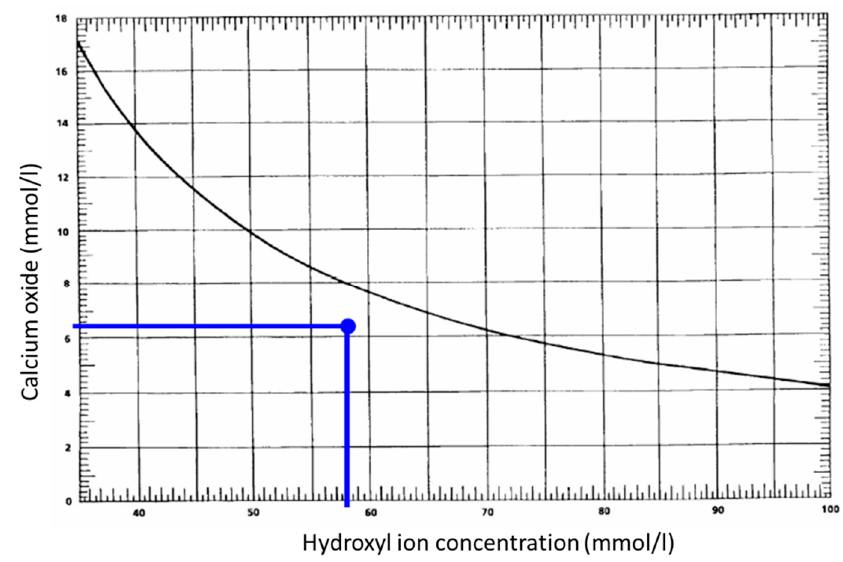
Figure 12. Pozzolanicity test results.